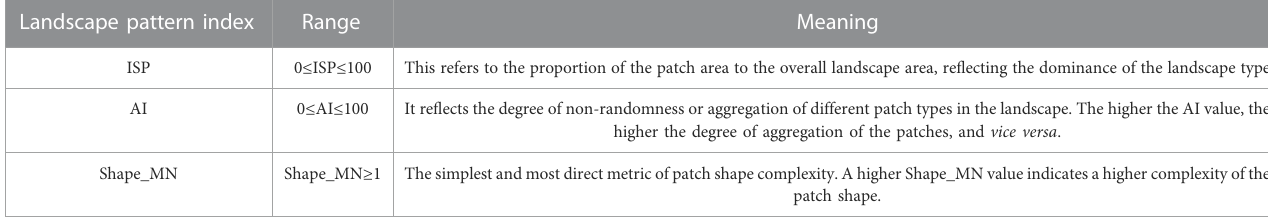
TABLE 2 Landscape pattern index. Landscape pattern index Range